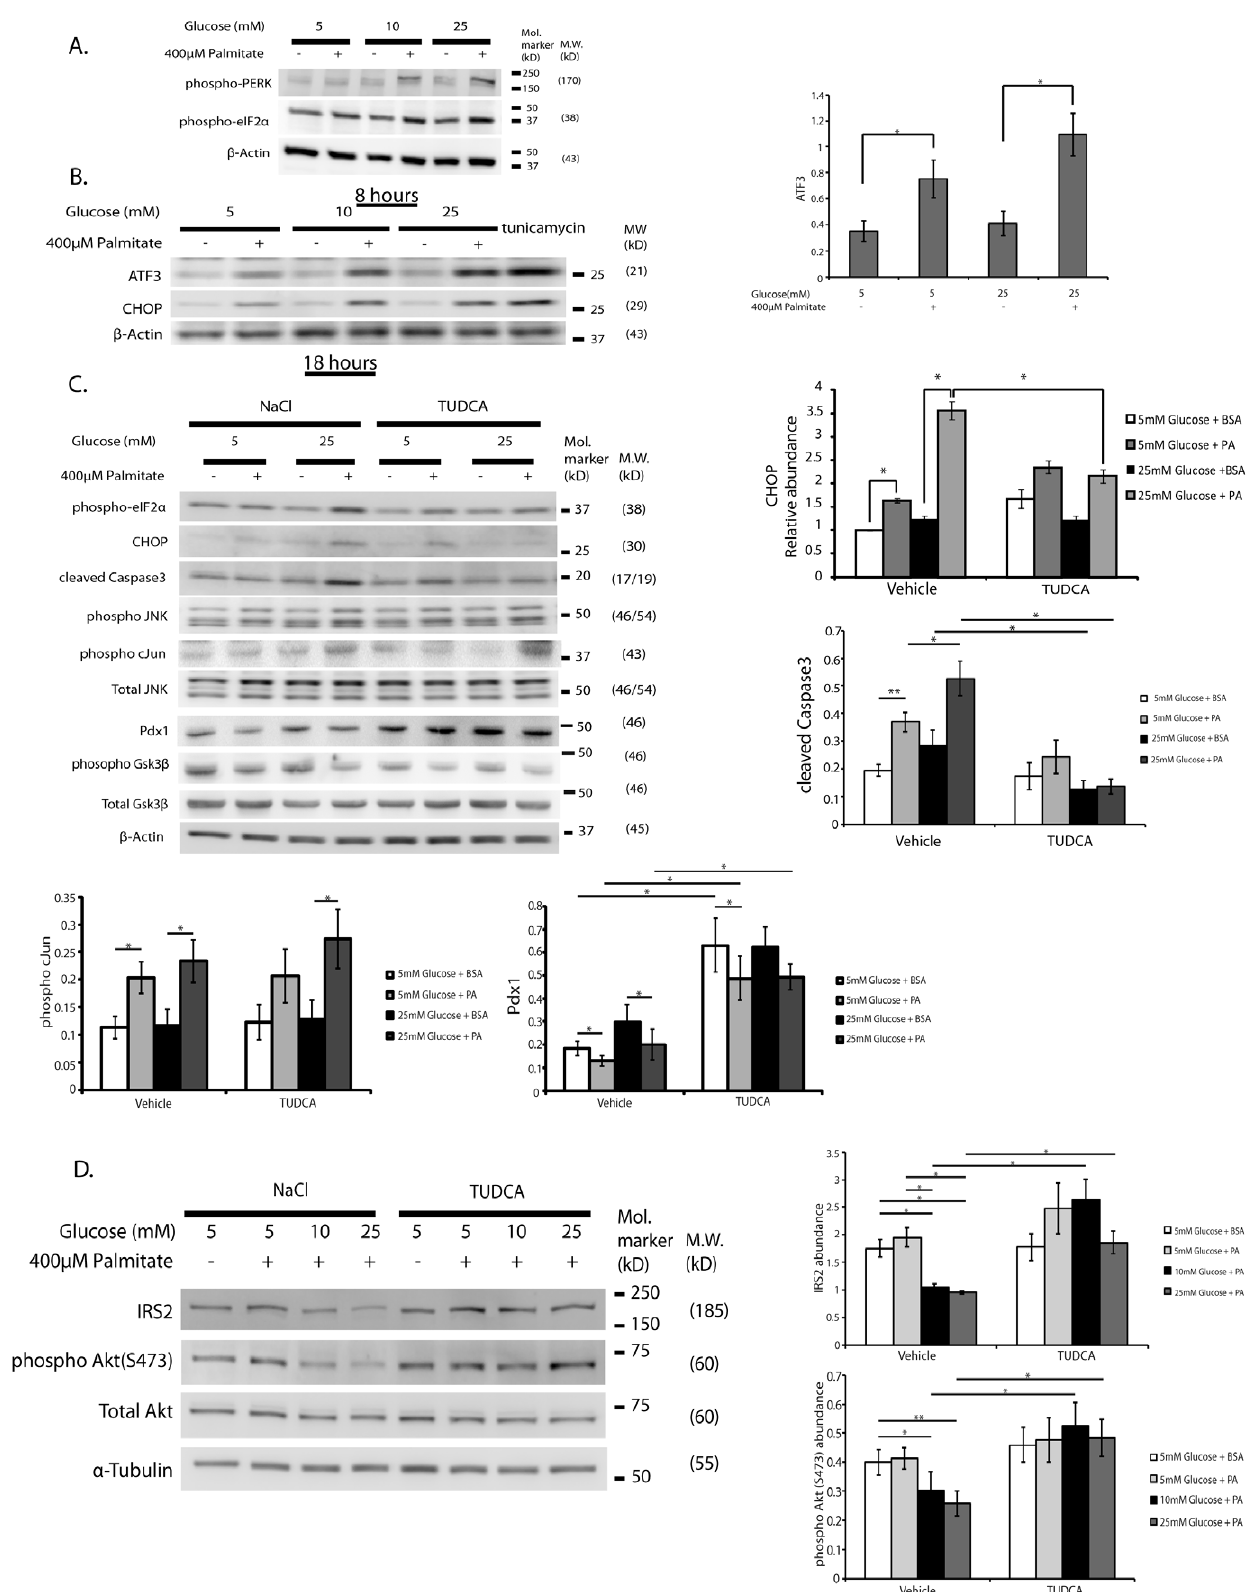
Figure 3. The synergistic effects of glucose and palmitate on ER stress and reduction of insulin signaling is attenuated by addition of a chemical chaperon. ( A ) MIN6 cells were treated with either control 0.5% BSA or 400 m M palmitate + 0.5% BSA at a concentration of 5, 10, 25 mM glucose for 8 hours. Total cell lysates were extracted at indicated time points and were subjected to Western blot analysis using anti-